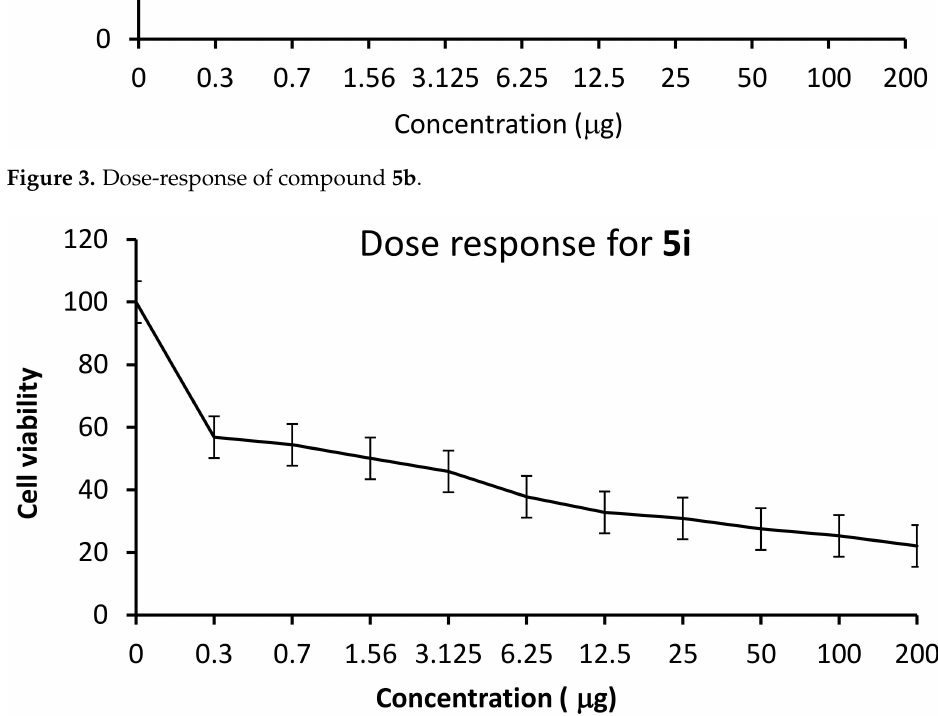
Figure 4. Dose-response of compound 5i